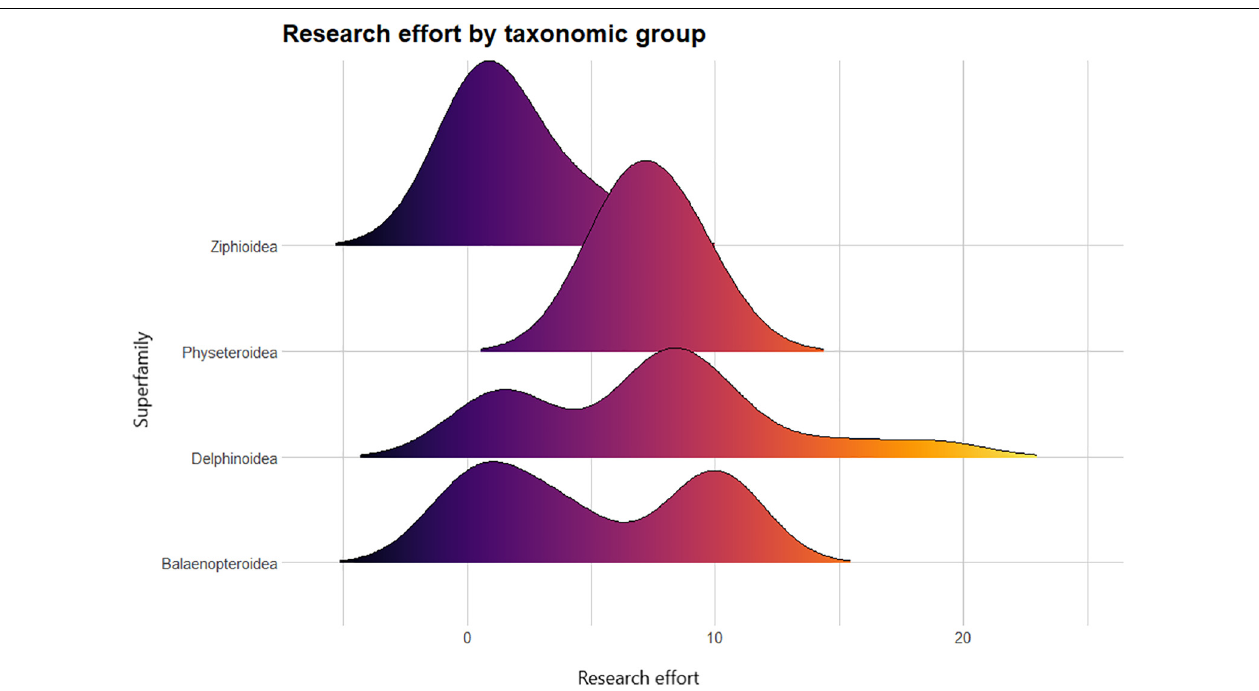
FIGURE 6 | A density distribution of research effort on marine mammal taxa in the Philippines from 1991 to 2020. The color gradient indicates the research effort, with warmer colors indicating more research output. This figure demonstrates that a substantial number of species have not been mentioned in a published research (particularly true for most ziphiids). The panel for dolphins shows two peaks and a skewed tail signifying some species receiving more research attention than others. The second peak for baleen whales is due to dedicated research on the humpback whales. The Family: Dugongidae is removed from the panel because of having only one representative